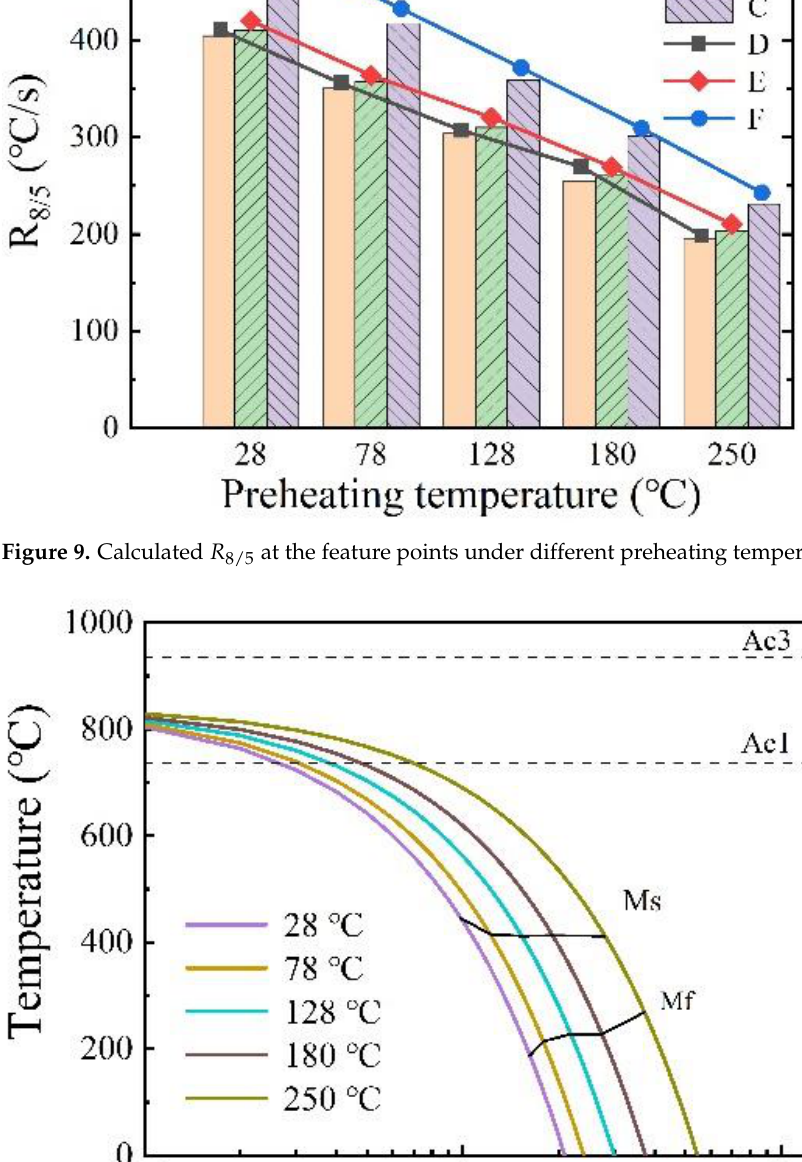
Figure 10. CCT diagram of AH36.